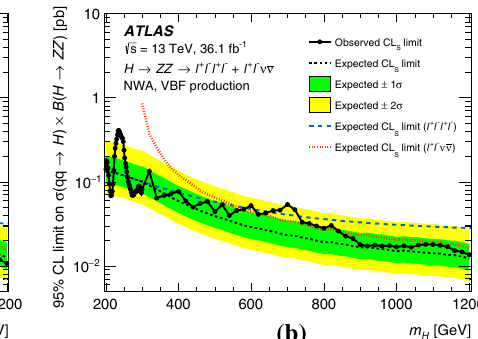
ized to a cross section corresponding to five times the observed limit given in Sect. 8.3.1. The error bars on the data points indicate the statis- ticaluncertaintyandmarkersaredrawnatthebincentre.Thesystematic uncertainty in the prediction is shown by the hatched band. The lower panels show the ratio of data to prediction